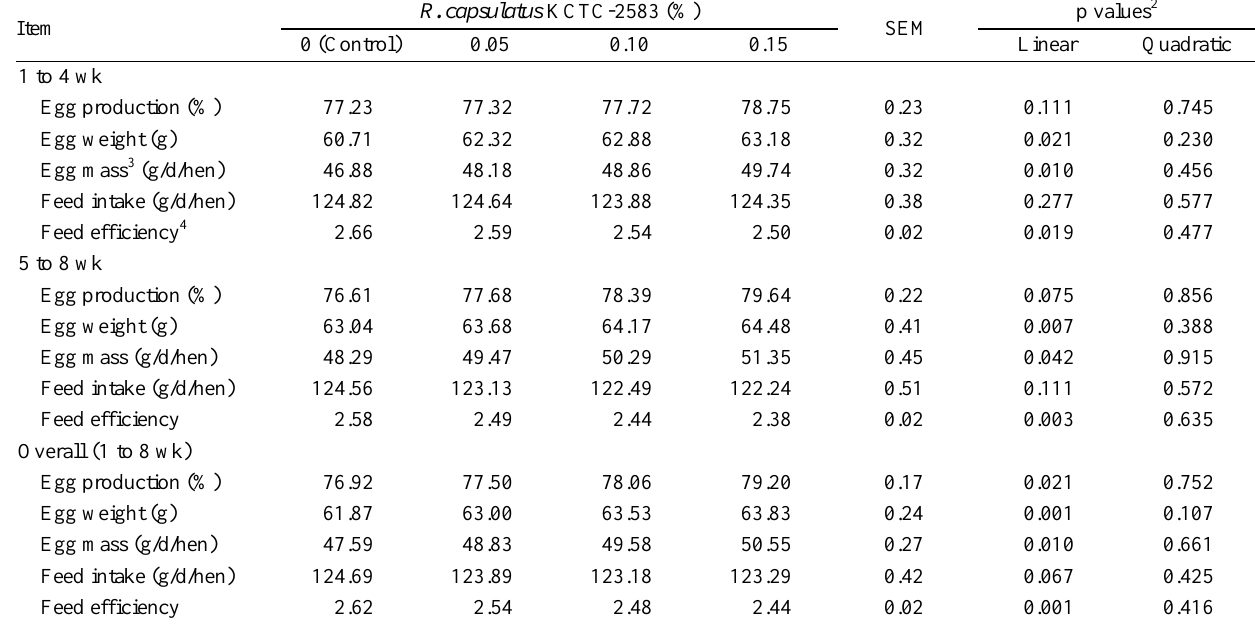
Table 4. Effects of dietary supplementation of Rhodobacter capsulatus KCTC-2583 on egg production, egg weight, egg mass, feed intake and feed efficiency in laying hens